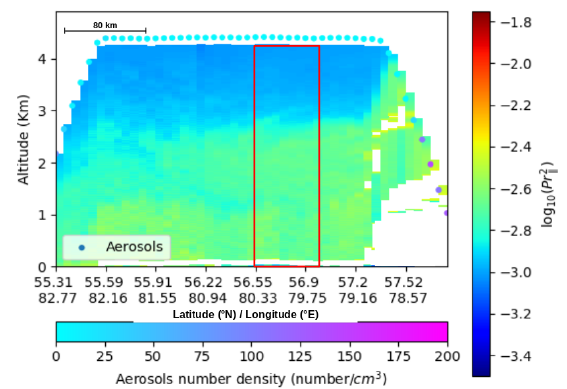
Fig. 2: Vertical cross-section of airborne lidar log (PR2) on June, 16 2017 . Calibration constant 10 is 13458 ± 2%. Grimm aerosol concentrations in particle.cm -3 are shown at the aircraft altitude. The FLEXPART simulation (Fig. 3) potential emission sensitivity (PES) is used to identify the possible aerosol sources (PES > 2000 s). Both aerosol emissions from the Novosibirsk area and from Kazakhstan can explain the layers seen by the airborne lidar.